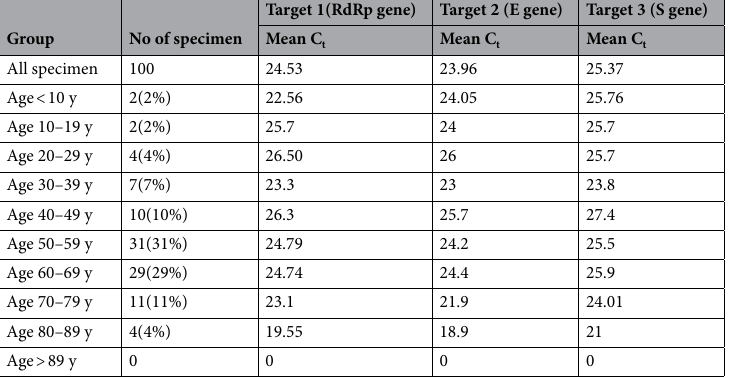
Table 2. Mean C t values obtained for the entire three targets among the positive specimens, stratified by age. Age group 80–89 showed considerably lower C t value for the entire three targets in comparison to mean C t which is representative of high viral